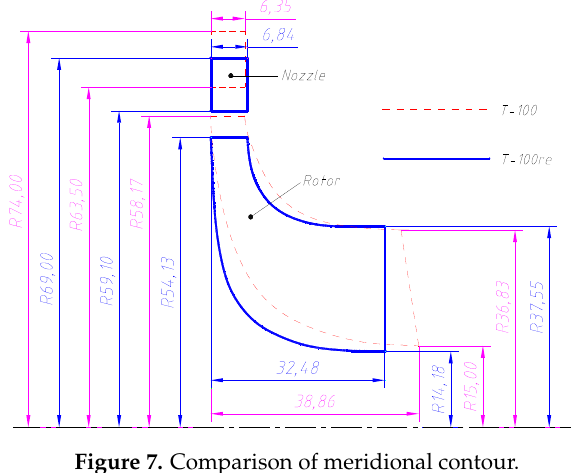
Figure 7. Comparison of meridional contour.